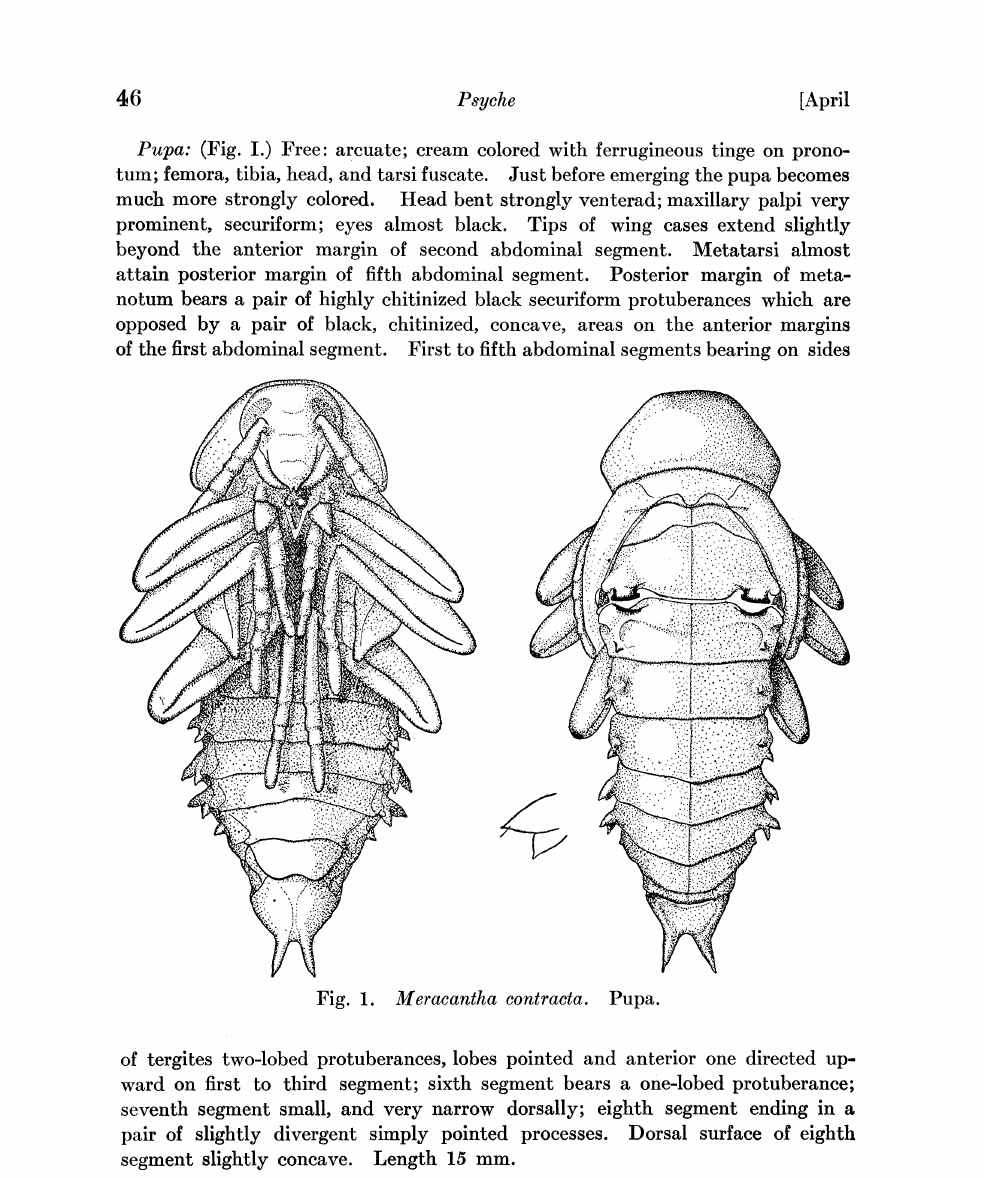
Fig. 1. Meracantha contracta.